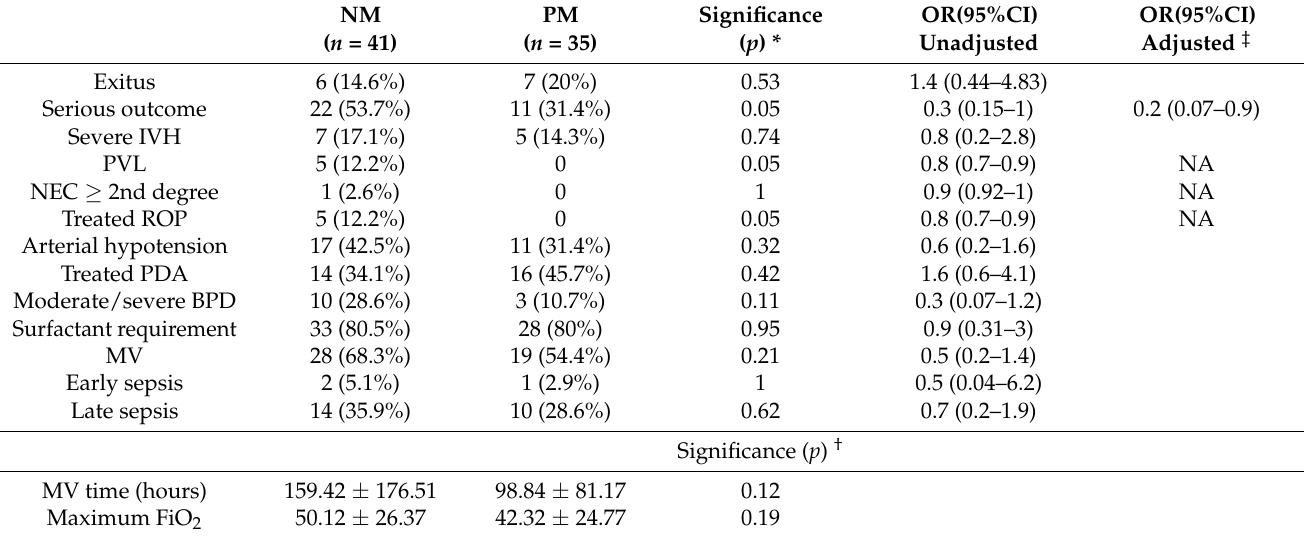
Table 2. Neonatal outcomes of cohort comparison according to maturation